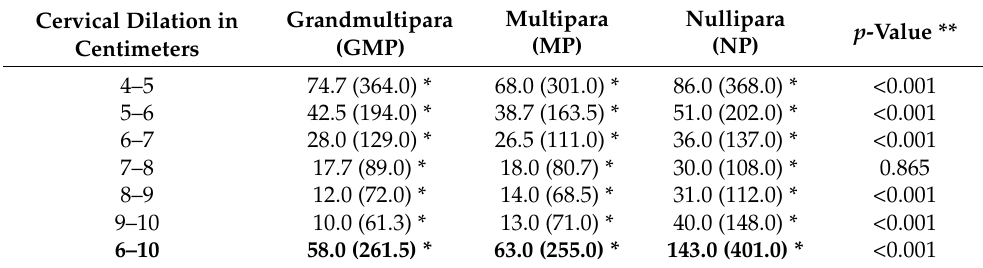
Table 2. Traverse times of cervical dilation